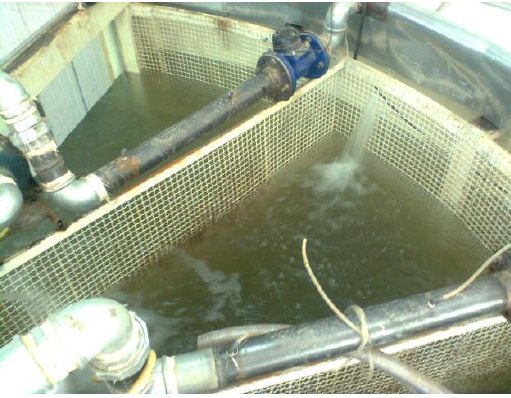
Figure 1. Schematic of the physical model used in the study Table 1. Specification of the aggregates used in the physical